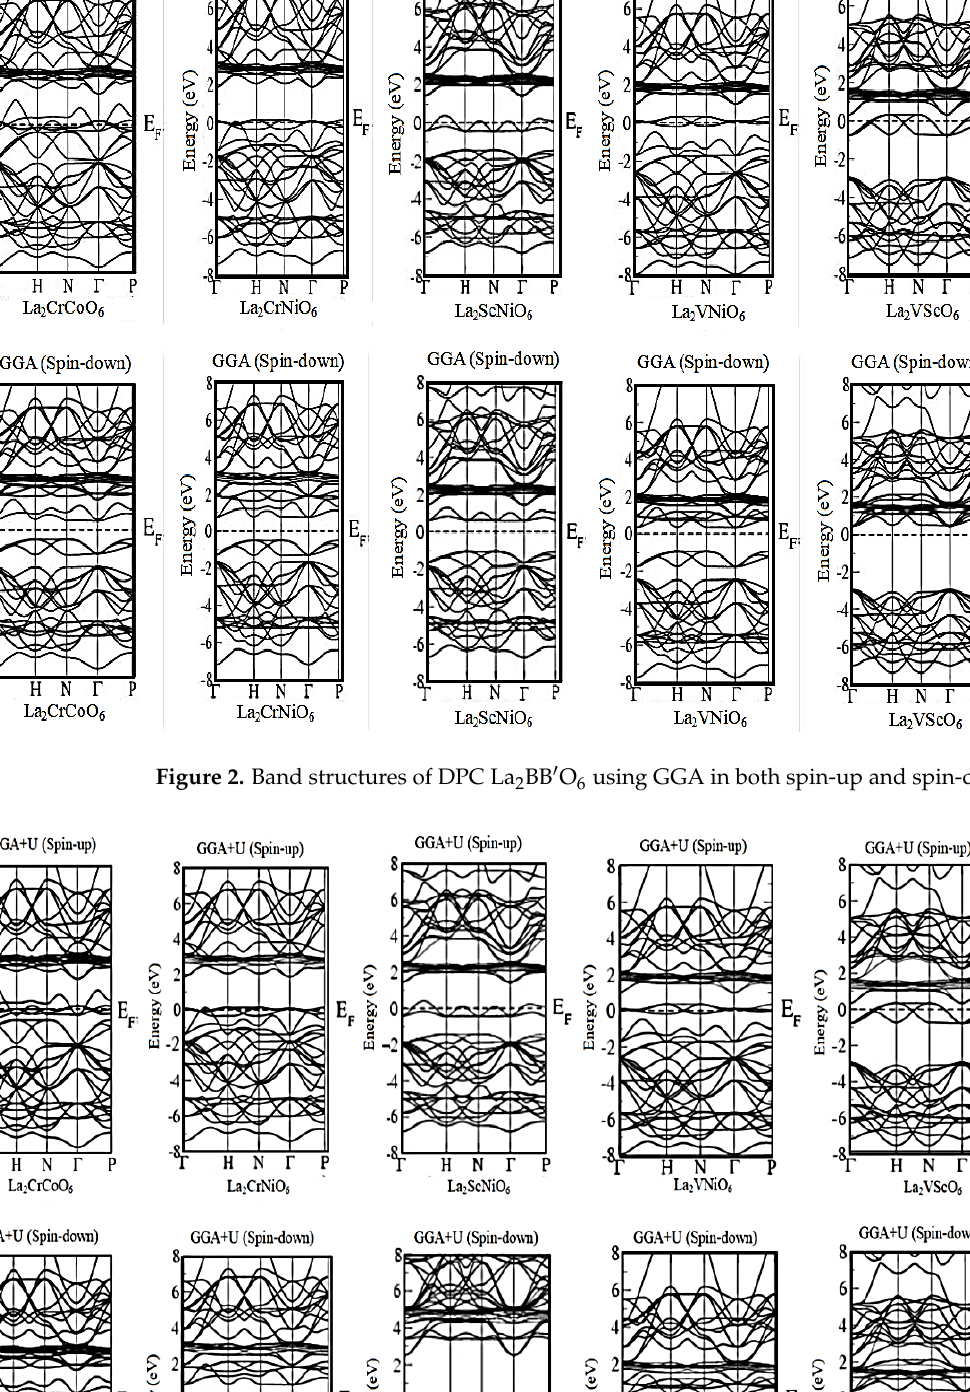
(cid:48) O 2 BB 6 using GGA+U in both spin-up and spin-down